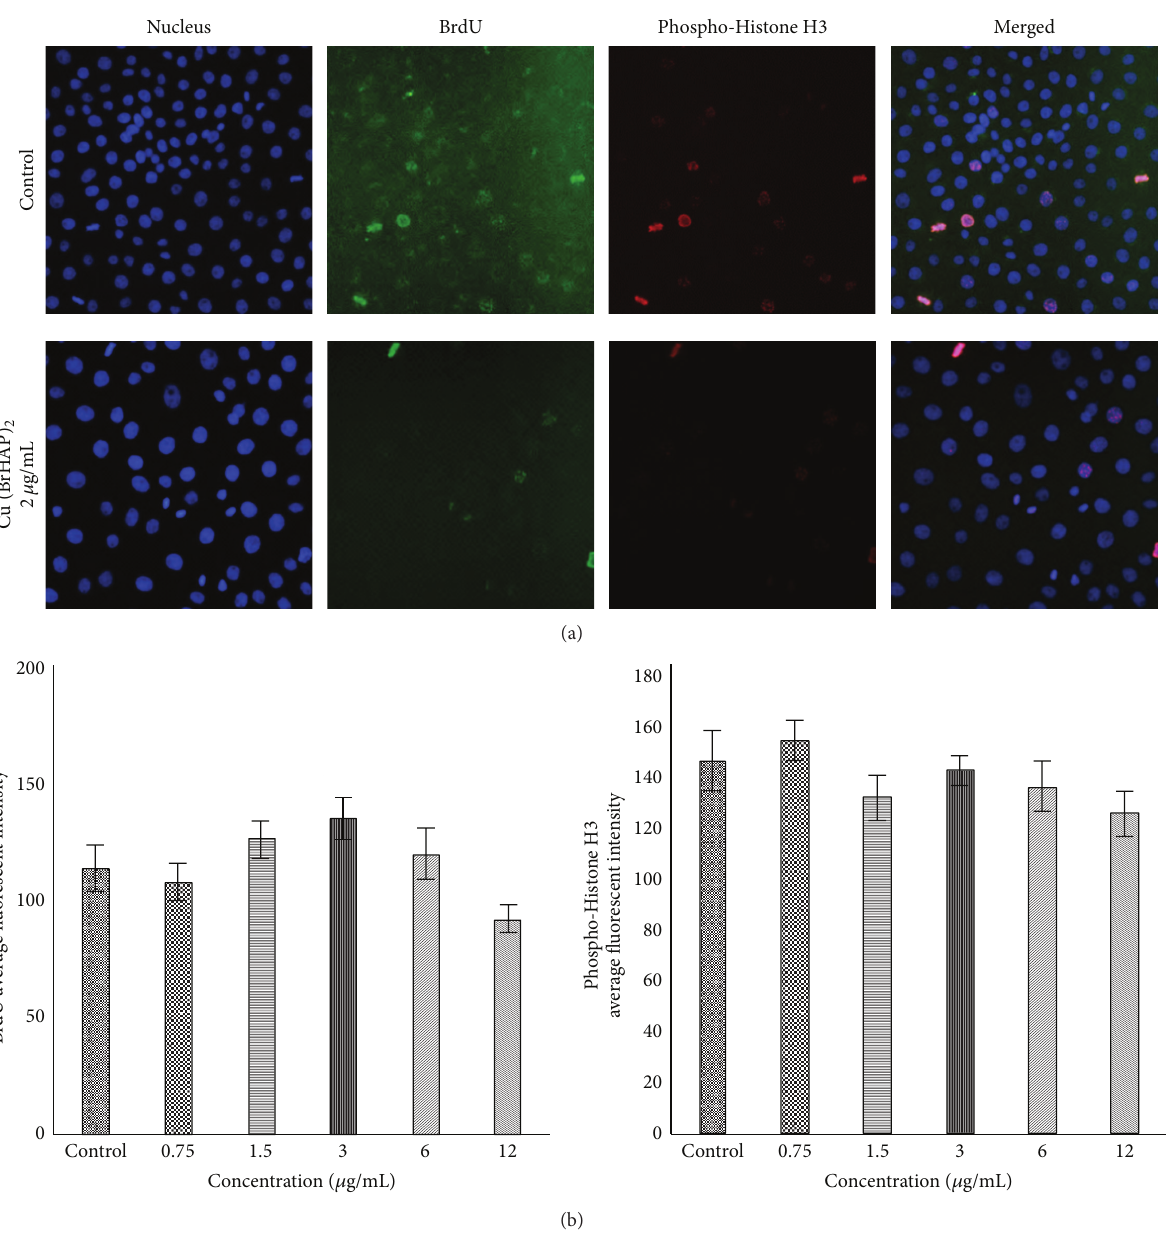
Figure 4: (a) Effect of Cu(BrHAP) 2 on cell cycle arrest in the S/M phase. After incubation with DMSO or Cu(BrHAP) 2 at 2 𝜇 g/mL for 24 h, HT-29 cells were collected, stained with BrdU and Phospho-Histone H3, and subjected to the Cellomics ArrayScan HCS reader for cell cycle analysis. (b) Representative bar charts indicating that Cu(BrHAP) 2 treatment caused no significant changes in BrdU or Phospho-Histone H3 fluorescence intensities in treated HT-29 cells. Cu(BrHAP) 2 induced no cell cycle arrest at the S/M phases in treated HT-29 cells. Data were expressed as the mean ± SD of fluorescence intensity readings for three independent